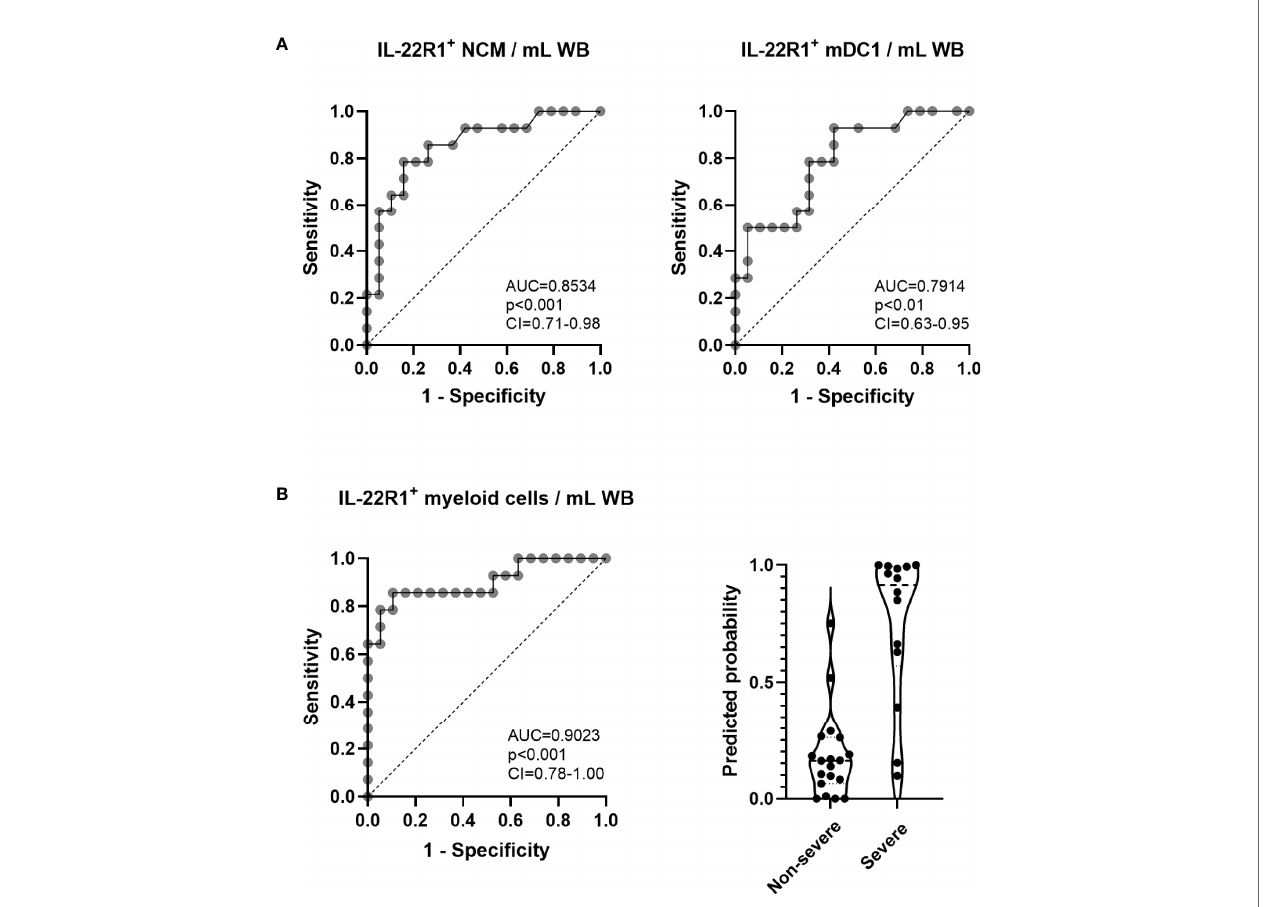
FIGURE 4 | Receiver operating characteristic (ROC) curves and logistic regression analysis of IL-22R1 + myeloid cells to discriminate severe from non-severe COVID- 19 patients. (A) ROC curves of IL-22R1 + non-classical monocytes (NCM) and myeloid DC1 (mDC1) were performed to compare severe from non-severe COVID-19 patients. The dotted lines represent an AUC of 0.5. (B) ROC curve of IL22R1+ myeloid cells and the predicted probabilities of logistic regression model in non-severe (n=19) and severe (n=14) COVID-19 patients. The dotted line shown on the ROC curve represents an AUC of 0.5. The dotted horizontal lines on panel (B) (right part) represent the medians of the linear prediction values. AUC, area under the ROC curve; CI, con fi dence interval; WB, whole